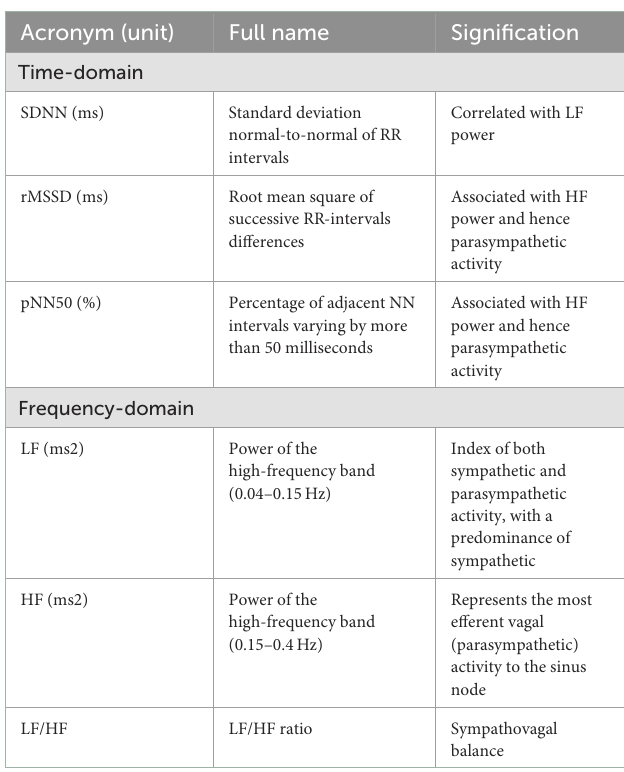
TABLE 1 Descriptive characteristics of HRV